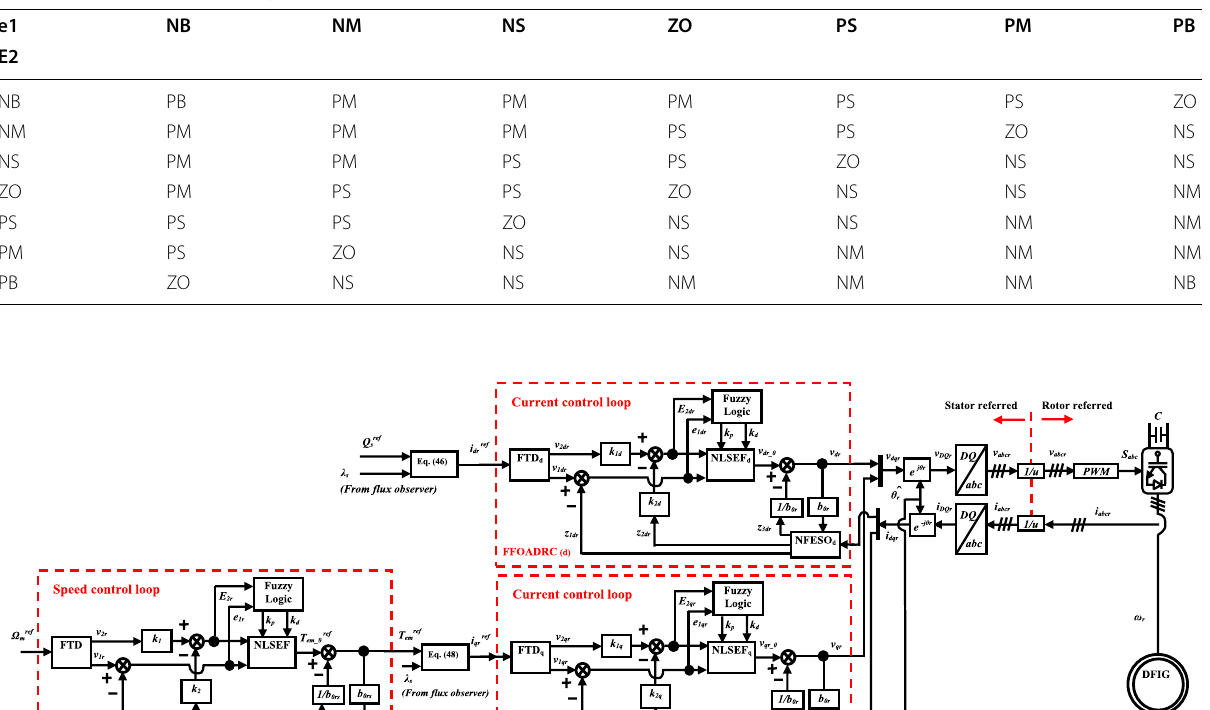
Table 2 Fuzzy rules used for k